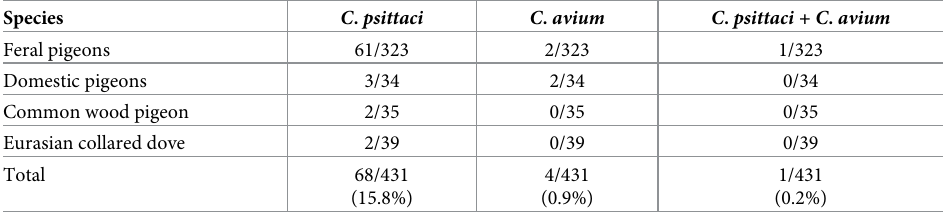
Table 4. Number of samples (positive/total) for Chlamydia species detected in different pigeon